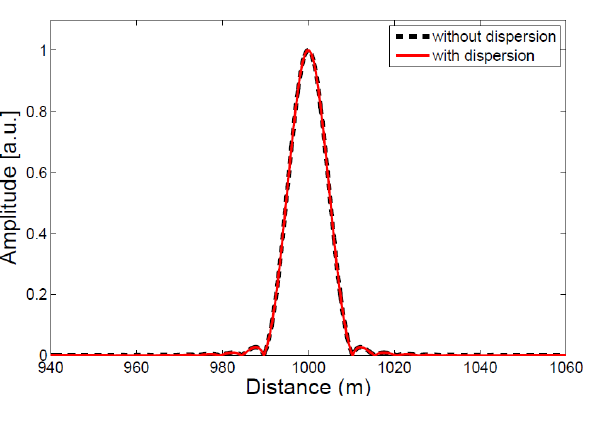
Figure 9. Comparison between the normalized Fourier peaks with and without dispersion effects. The thick black dashed curve is the Fourier peak contributed by light at  dispersion, while the red curve is the Fourier peak computed from Equation (13). The Fourier transform was calculated with a Hann window and a fast Fourier transform size of 2 20 .